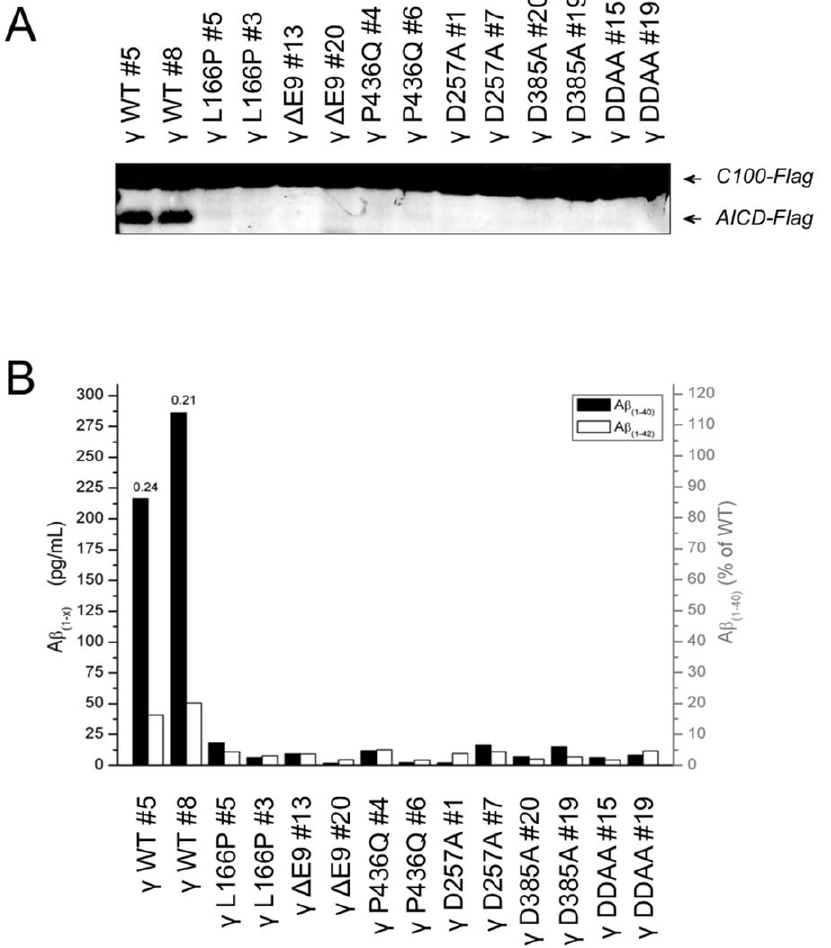
Figure 5. Enzymatic activity of highly purified c -secretase complexes with FAD-linked or aspartate PS1 mutants. Equal amounts of the different purified c -secretase preparations characterized in Figure 4 were tested for activity on C100-Flag, as described in Figure 3. The resulting cleavage products were separated by SDS-PAGE and detected by immunostaining with an anti-Flag antibody (M2) for C100-Flag or AICD-Flag (A), and by sandwich ELISA for A b 1–40 or A b 1–42 (B). Note that the levels of A b produced from FAD-linked c -secretase complexes were all in the non-linear range of the ELISA standards, close to the detection limit. Whenever possible, A b 1–42/A b 1–40 ratios were quantified and indicated on the top of the bars. Two independent purifications were performed on each clone and similar results were obtained. A representative dataset is shown.